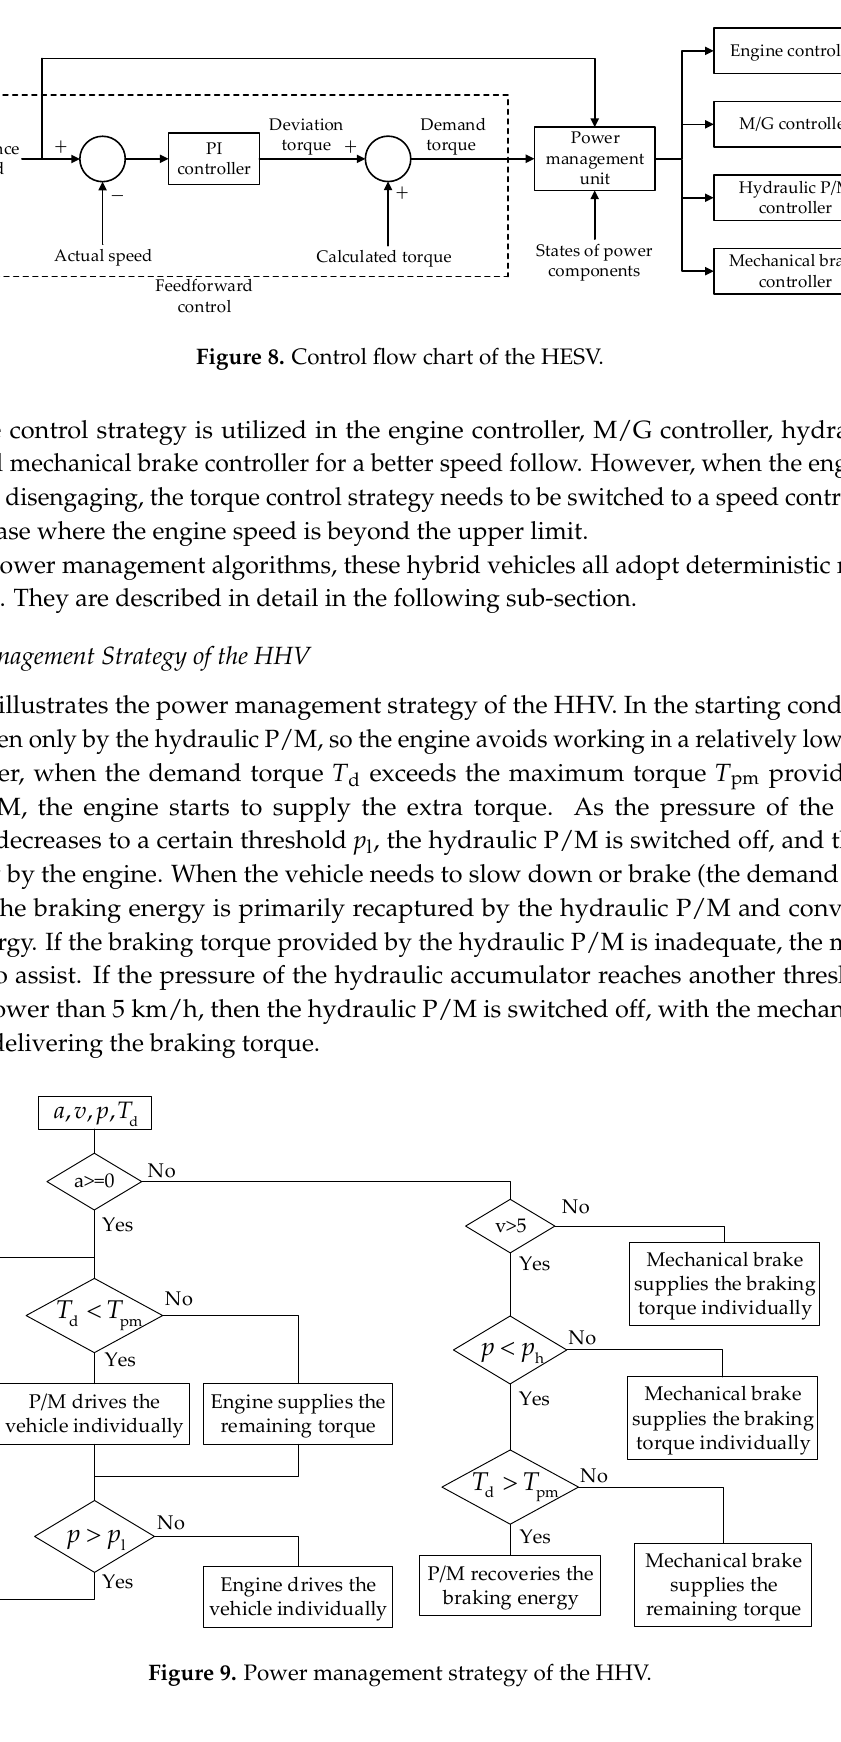
Table 4. Gear-shifting rules of the HHV. Gear